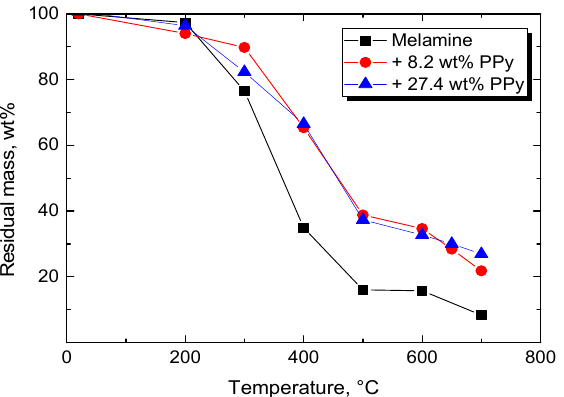
Figure 3. The residual mass of melamine sponge (black squares) and polypyrrole-coated melamine sponges after exposure to elevated temperature.